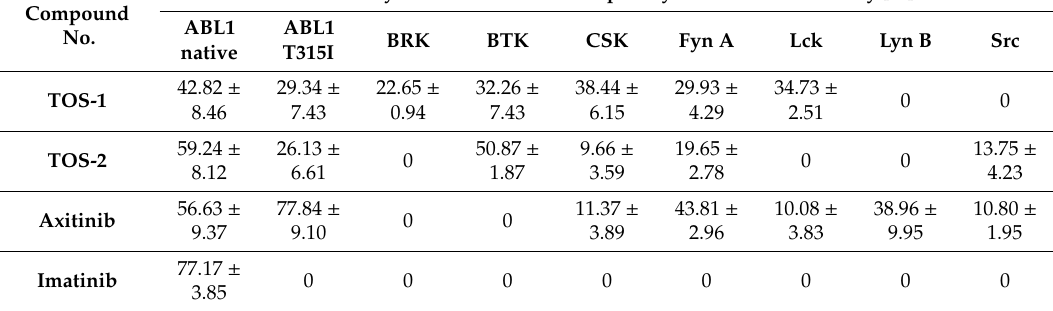
Table 1. Inhibition of the activity of the kinases after treatment with the IDH1 inhibitors axitinib and imatinib that were tested at a concentration of 0.5 µ M.